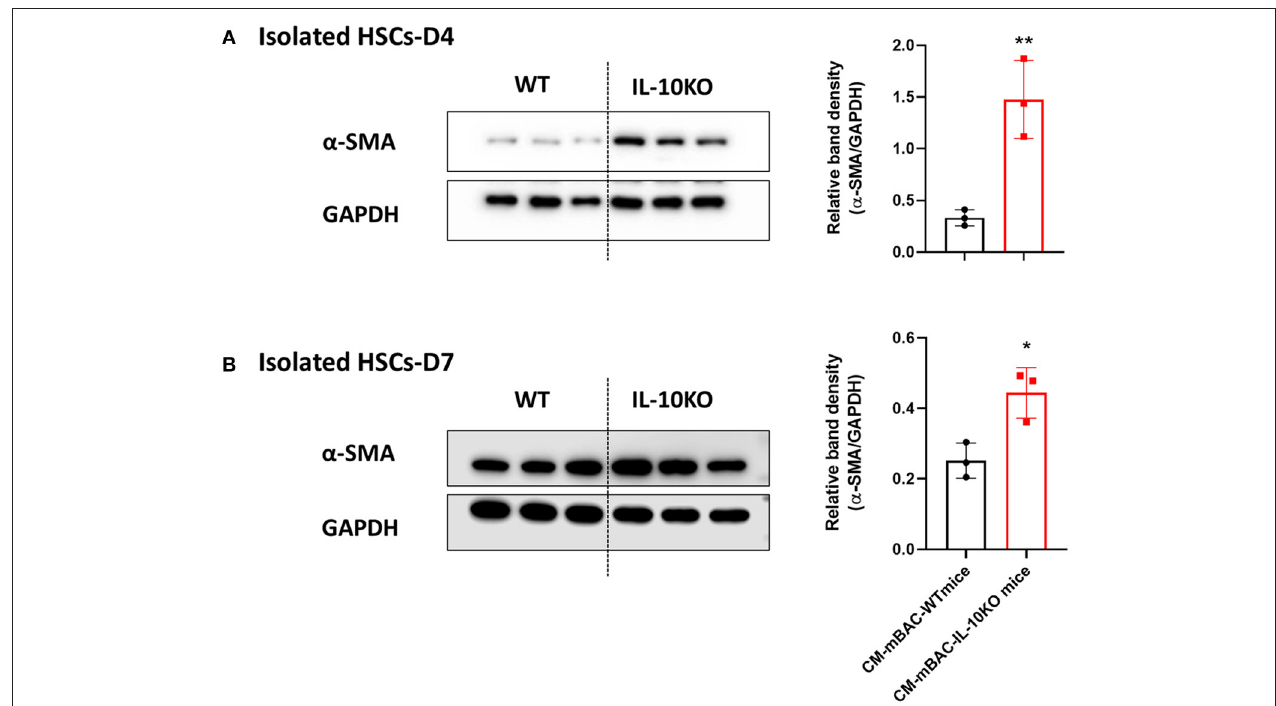
FIGURE 7 | Conditioned media from IL-10-deficient brown adipocytes increased HSCs activation. CM-mBAC was collected after 24h of culture of fully differentiated brown adipocytes. HSCs at day 4 (A) and day 7 (B) were cultured with CM-mBAC from WT and IL-10 KO mice. Statistically significant differences were determined by Student’s t- tests. * p < 0.05, ** p <